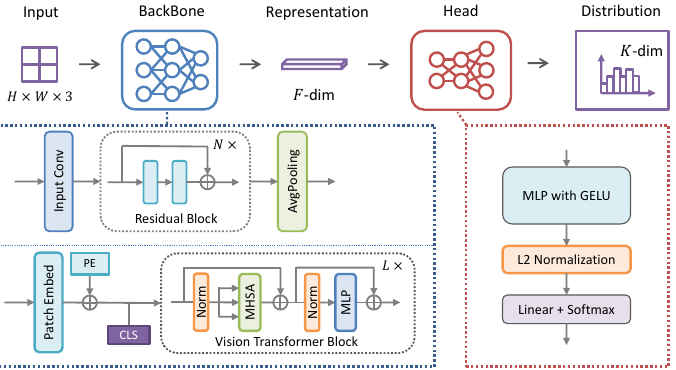
Figure 2. Overview of the network model. The backbone takes an image as input and outputs a F -dim vector as its representation. The head projects the representation vector into a K -dim distribution for knowledge distillation.